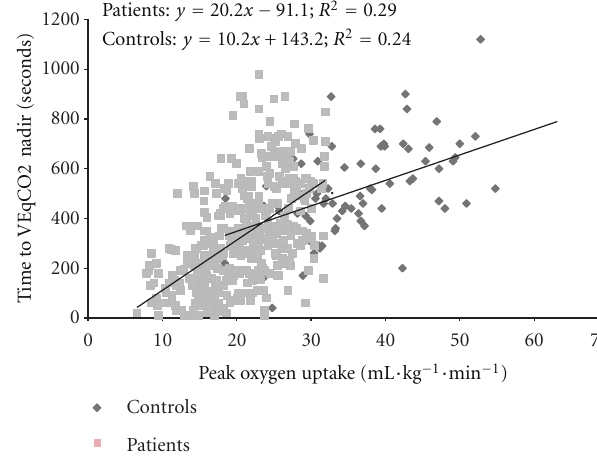
Figure 1: Relation between time to VEqCO2 nadir and peak oxygen uptake in patients with CHF and controls.